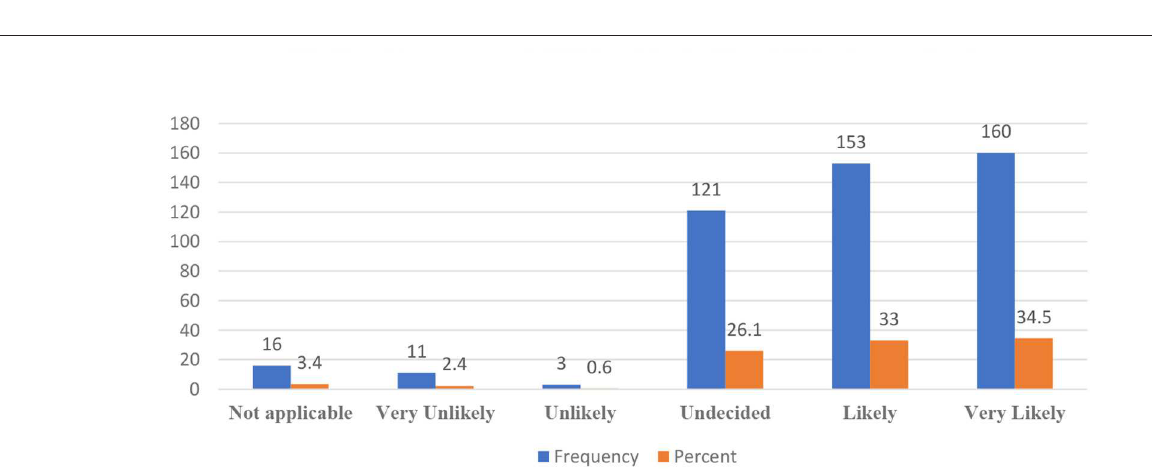
FIGURE 1 | The preference of parents toward modality of treatment for their children ( N = 464).